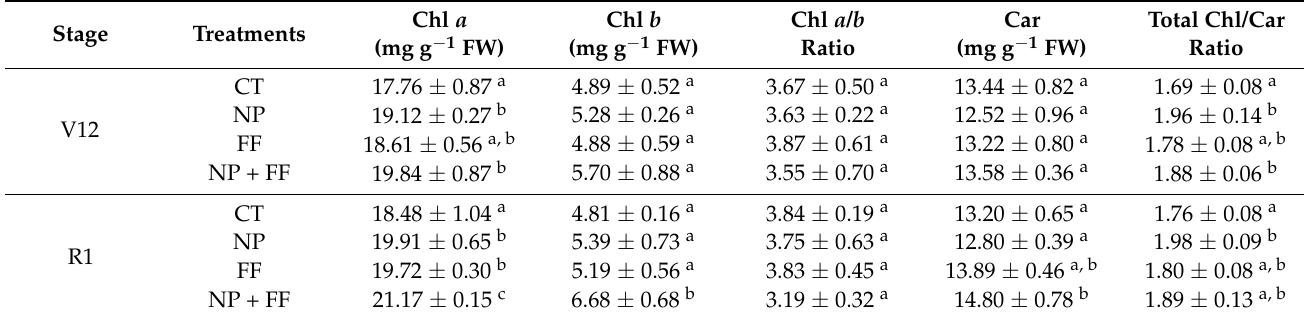
Table 1. The photosynthetic pigments of maize leaves as a result of each treatment at different phenological stages (V12 and R1).